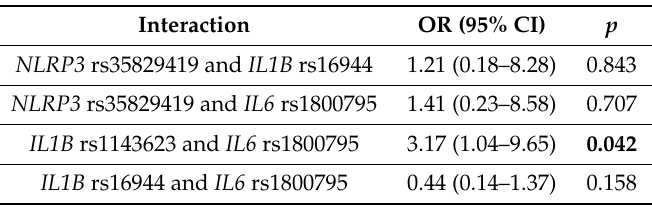
Figure 2. Time course of glucose and insulin levels for PON1 rs662. The blue line represents the reference genotype, while the green line represents patients with at least one polymorphic allele.